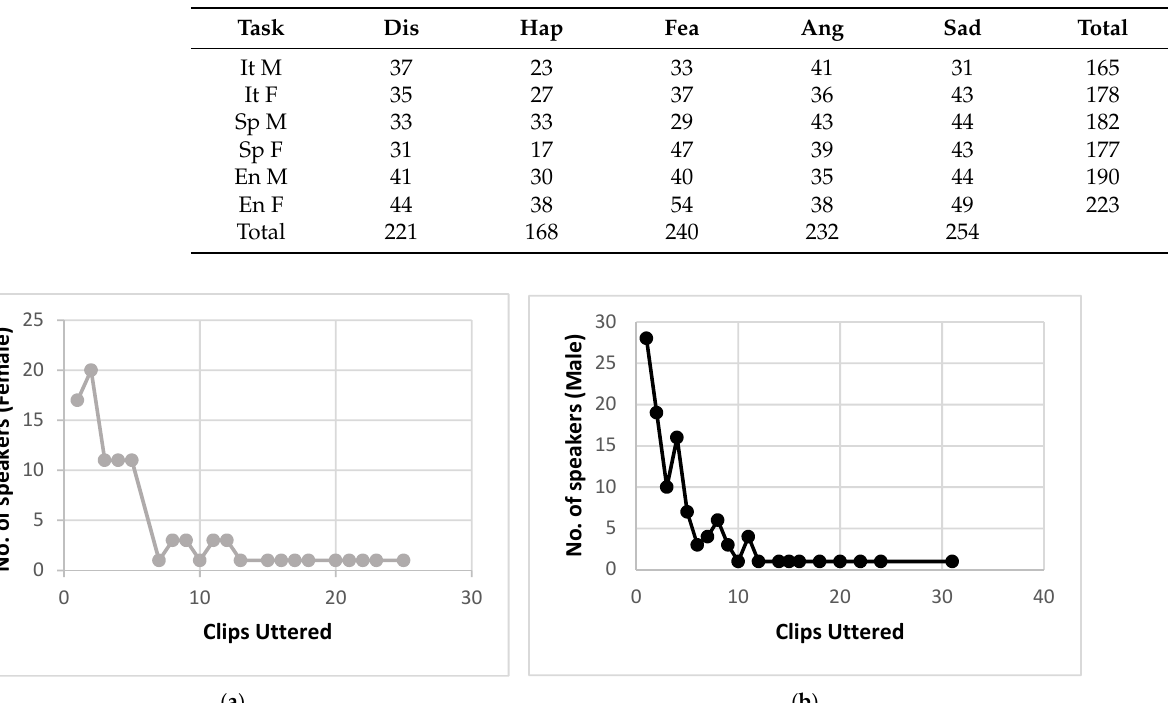
Table 2. Number of clips for each emotion, each language and each gender. As an example, “It M” means “Italian Males” and there are 37 clips of Italian males labelled with the “Disgust” emotion. Last column/row shows the total of clips for all emotions/tasks.